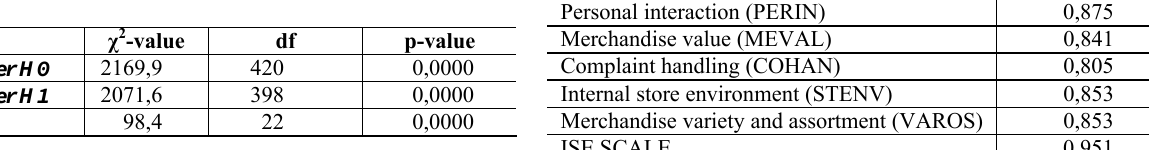
Table 9: Measurement error variances cross-validation: Chi-square difference test results